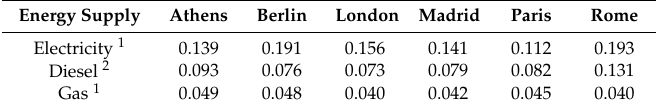
Table 1. Average national energy prices from 2012 to 2016 ( € kWh − 1 ).